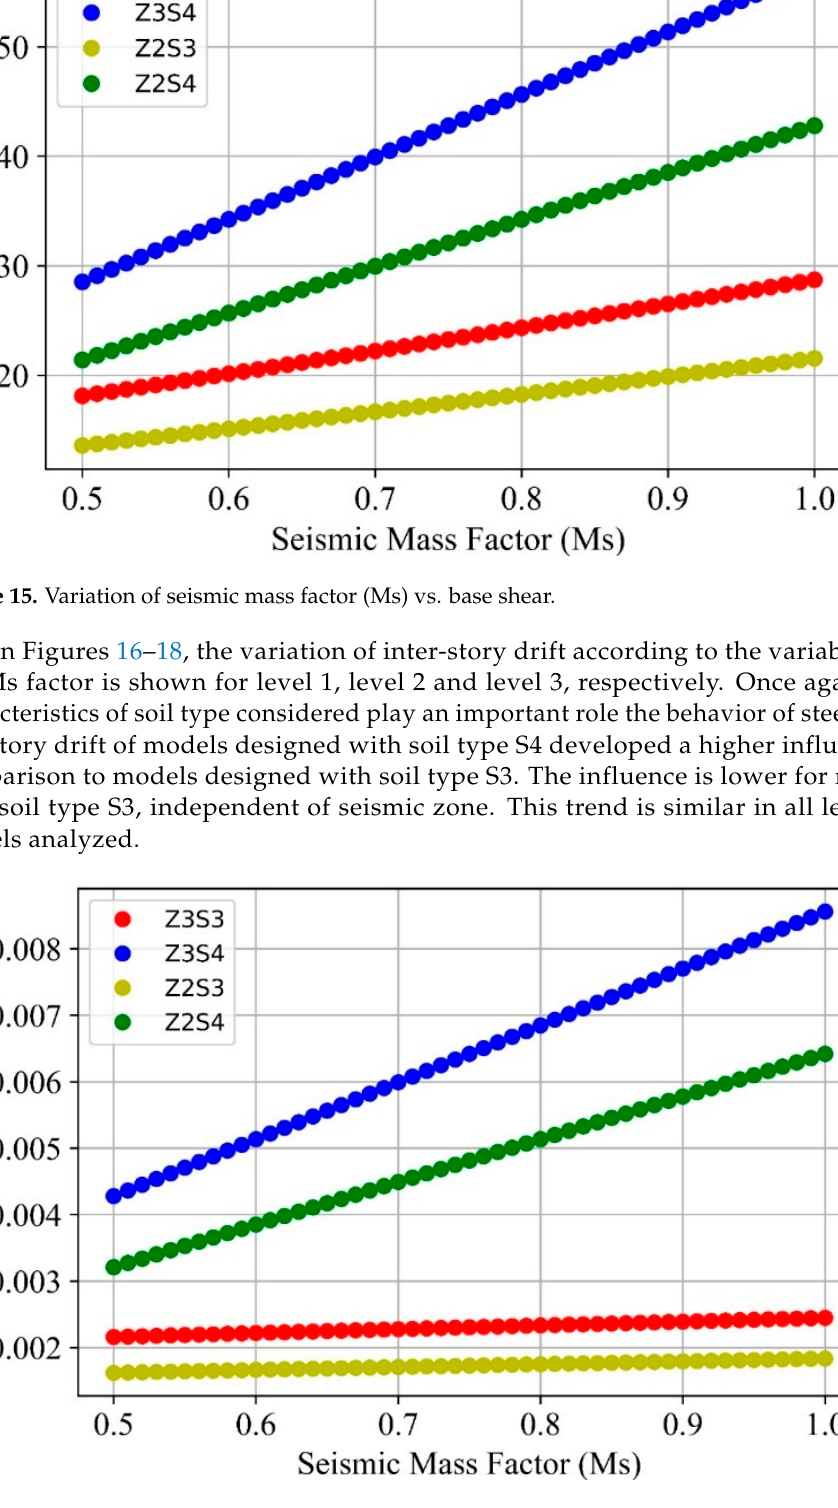
Figure 17. Variation of seismic mass factor (Ms) vs. drift at level 2.